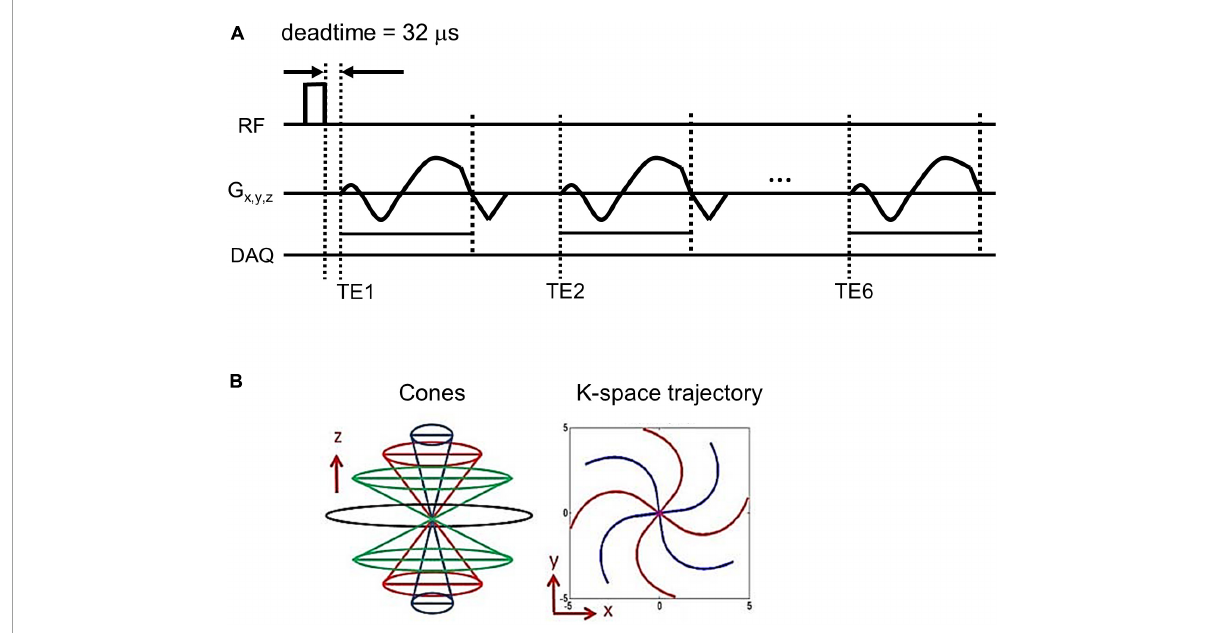
FIGURE1 Pulse sequence diagram. An ultrashort echo time quantitative susceptibility mapping (UTE-QSM) sequence (A) based on the efficient 3D cones trajectory (B) was implemented to acquire images at six different echo times for QSM processing (DAQ: Data acquisition).